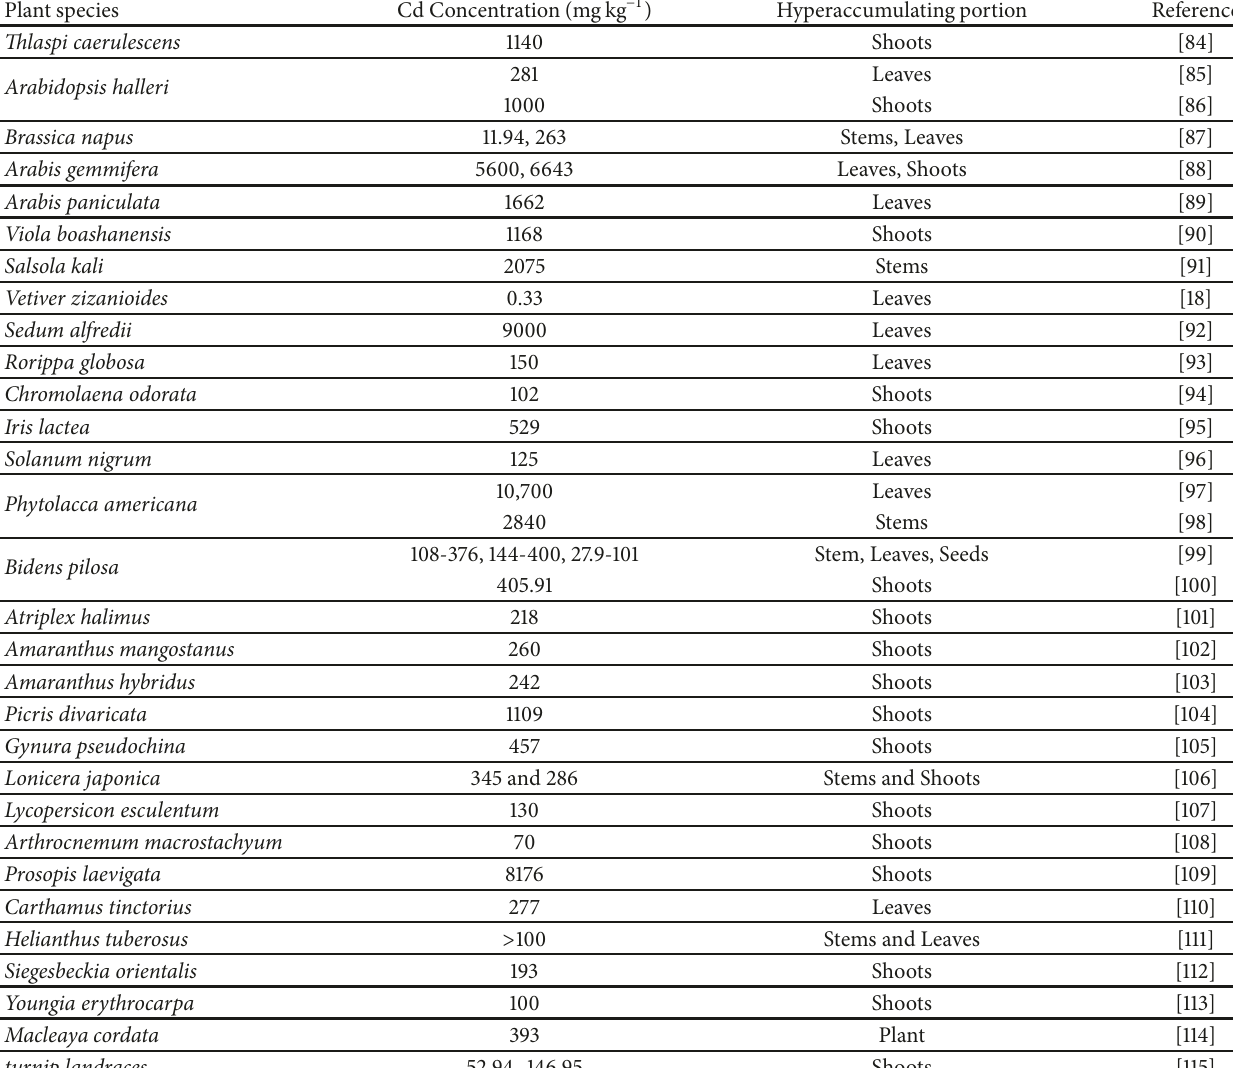
Table 3: Cd hyperaccumulators reported for phytoremediation in